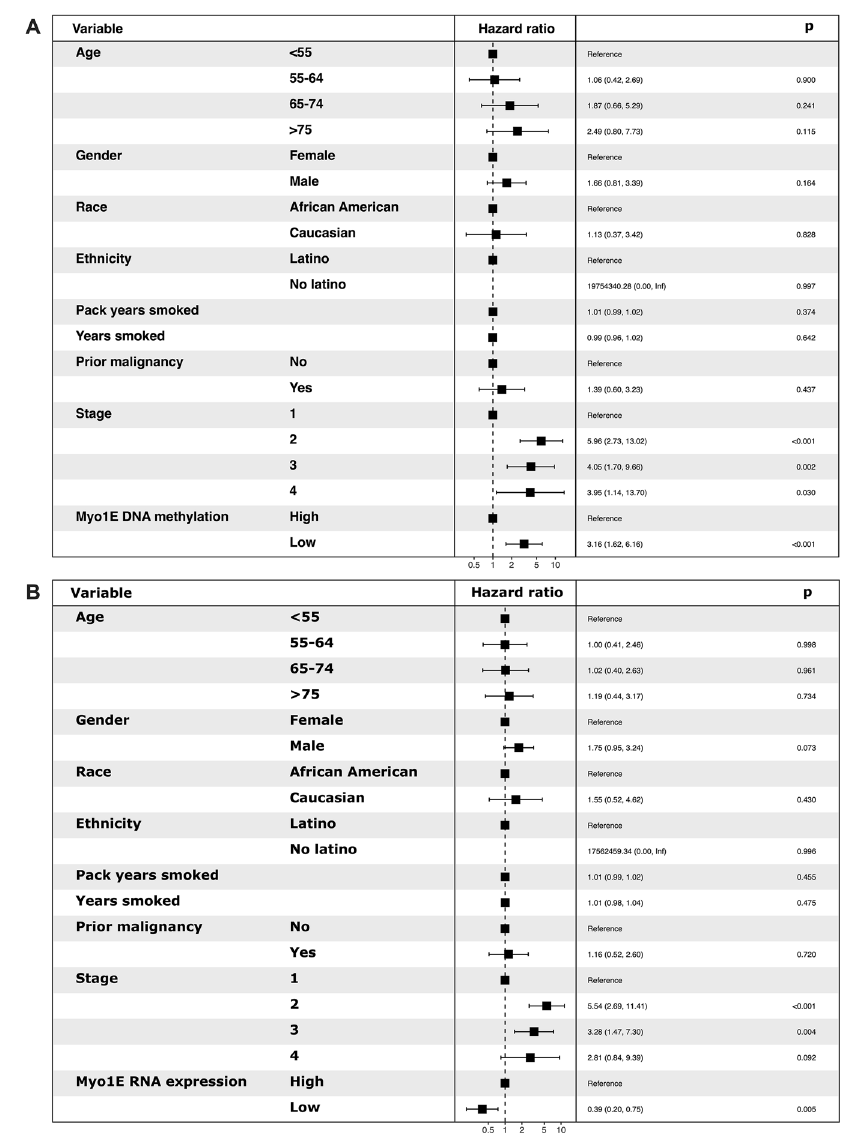
Figure 5. Low DNA methylation and high RNA expression of MYO1E are associated with increased mortality risk in LUAD. Forest plot for multivariate Cox proportional hazard analysis weighted for age, sex, race, Hispanic ethnicity, number of pack years smoked, number of years smoked, prior malignancy, histology, and stage in LUAD. ( A ) MYO1E DNA methylation, ( B ) MYO1E RNA